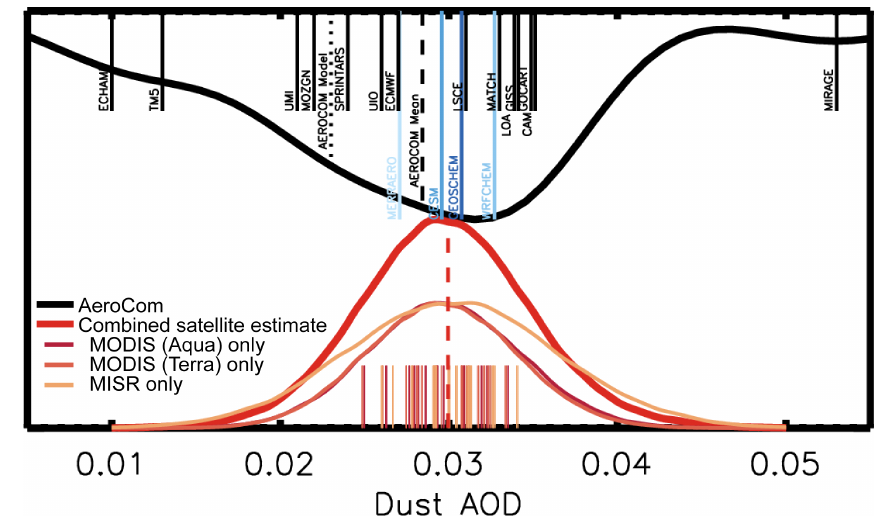
Figure 3. The global dust AOD adapted from Huneeus et al. (2011) for 14 AeroCom models (vertical black lines) and the associated probability density function (PDF) (solid black line), mean (dashed black line), and the AeroCom median model (dotted black line) are shown along with the global dust AOD from the four models used in this study (vertical blue lines). The PDF of the observationally constrained dust AOD estimate of this study (red) with the associated mean (dashed red line) is shown on the bottom axis. The PDF of the observationally constrained dust AOD derived from each of the satellite instruments is shown (red hues) with the individual ensemble members (vertical red hue lines).